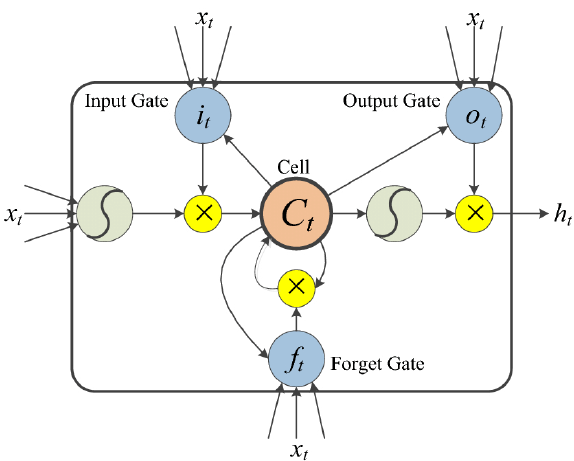
Figure 3. Internal structure of the LSTM unit